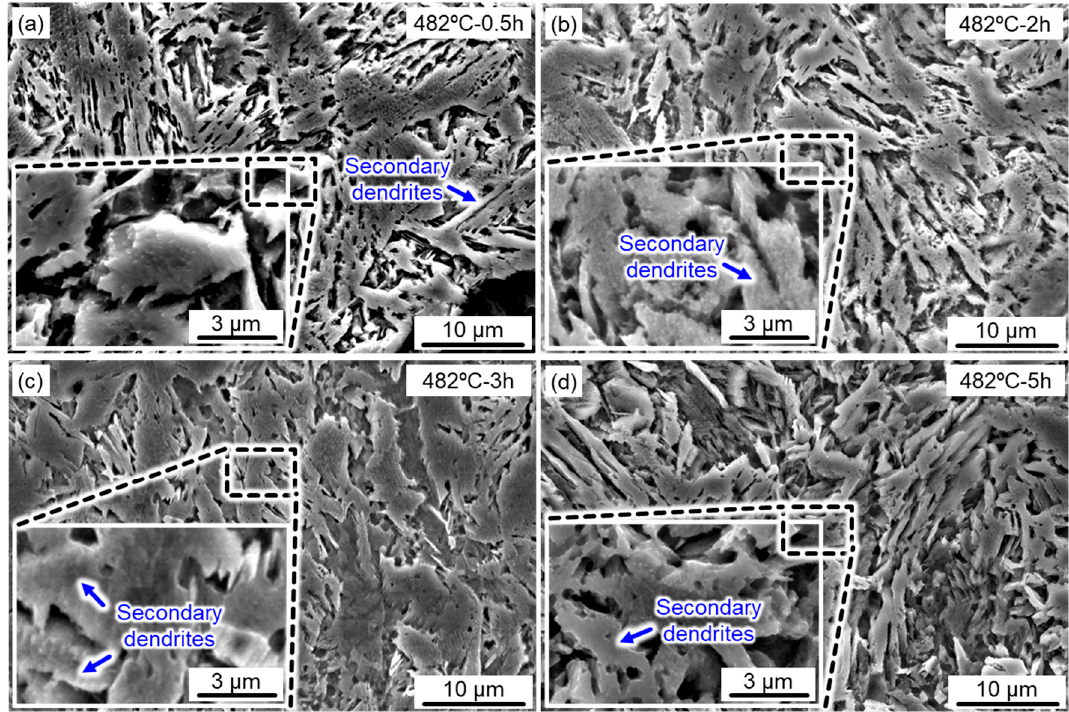
Figure 4. Microstructure features of the aged SLM 17-4 steel at 482 ◦ C for different holding times: ( a ) 0.5 h; ( b ) 2 h; ( c ) 3 h; ( d ) 5 h.